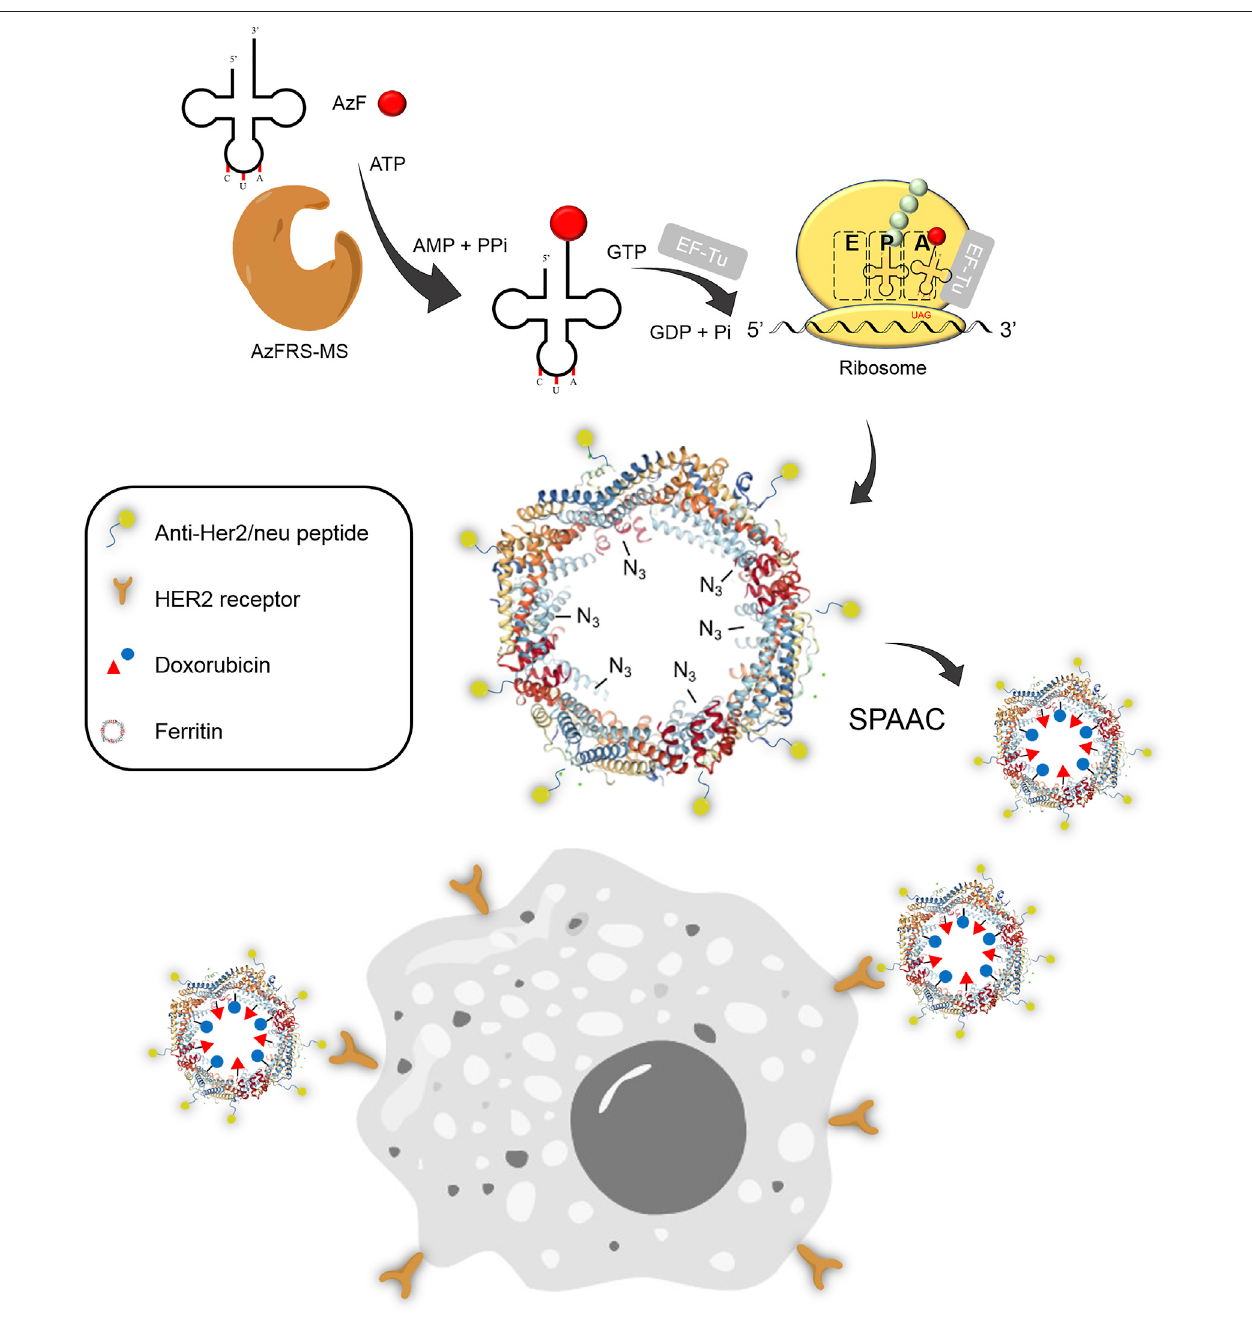
FIGURE 1 | Synthesis of the Ftn – Dox conjugate and the targeting of Her2 + breast cancer cells. The Ftn – Dox conjugate is synthesized through the expanding (cid:129) genetic code approach and the SPAAC reaction. The engineered AzFRS-MS tRNA Pyl pair is used to incorporate AzF ( 4 , red fi lled circle) into Ftn. The installed azido group is shown as − N 3 on the Ftn nanocage. The Ftn – Dox conjugate with the installed anti-Her2/neu peptide (AHNP) facilitates the targeting of breast cancer cells, BT474, in this study. SPAAC, strain-promoted alkyne-azide cycloaddition.